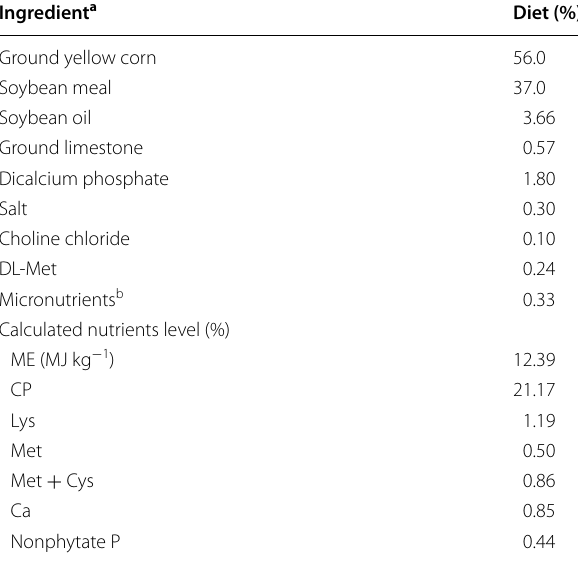
a Ingredient and nutrient composition are reported on as-fed basis b Micronutrients are provided per kilogram of diet: vitamin A (all-trans retinol acetate), 12,500 IU; cholecalciferol, 2500 IU; vitamin E (all-rac-a-tocopherol acetate), 18.75 IU; vitamin K (menadione Na bisulfate), 5.0 mg; thiamin (thiamin mononitrate), 2.5 mg; riboflavin, 7.5 mg; vitamin B6, 5.0 mg; vitamin B12, 0.0025 mg; pantothenate, 15 mg; niacin, 50 mg; folic acid, 1.25 mg; biotin, 0.12 mg; Cu (CuSO